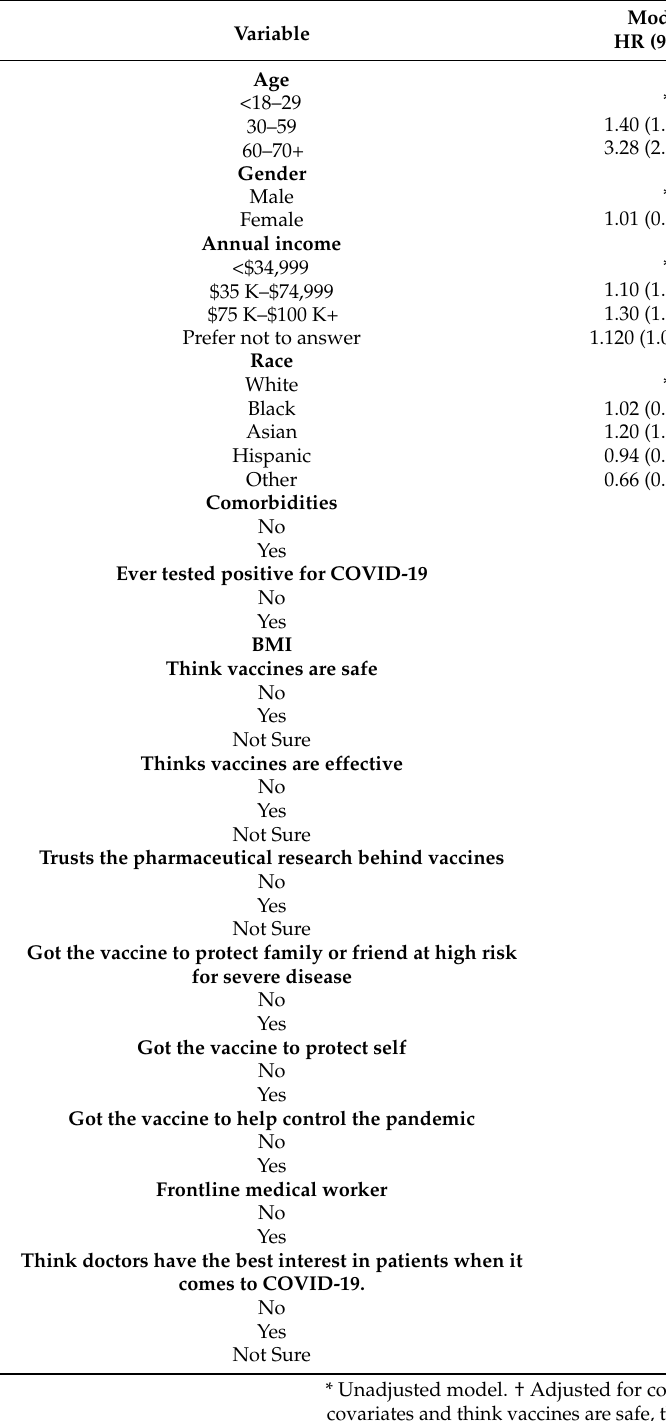
Table 2. Hazard ratios (HRs) for vaccine receipt by cox proportional hazards